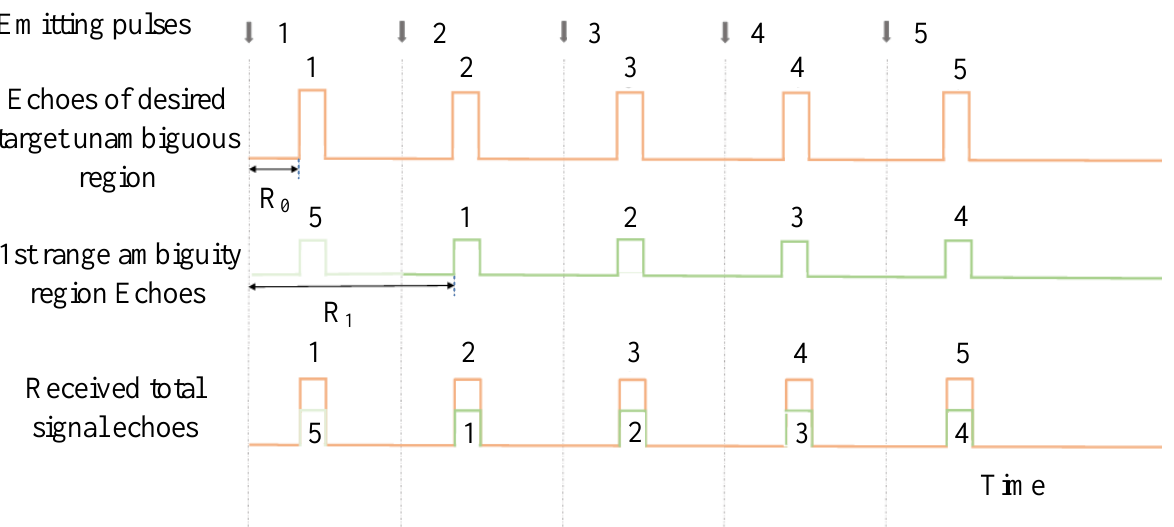
Figure 5. Schematic diagram of range-ambiguous clutter pulse echoes.